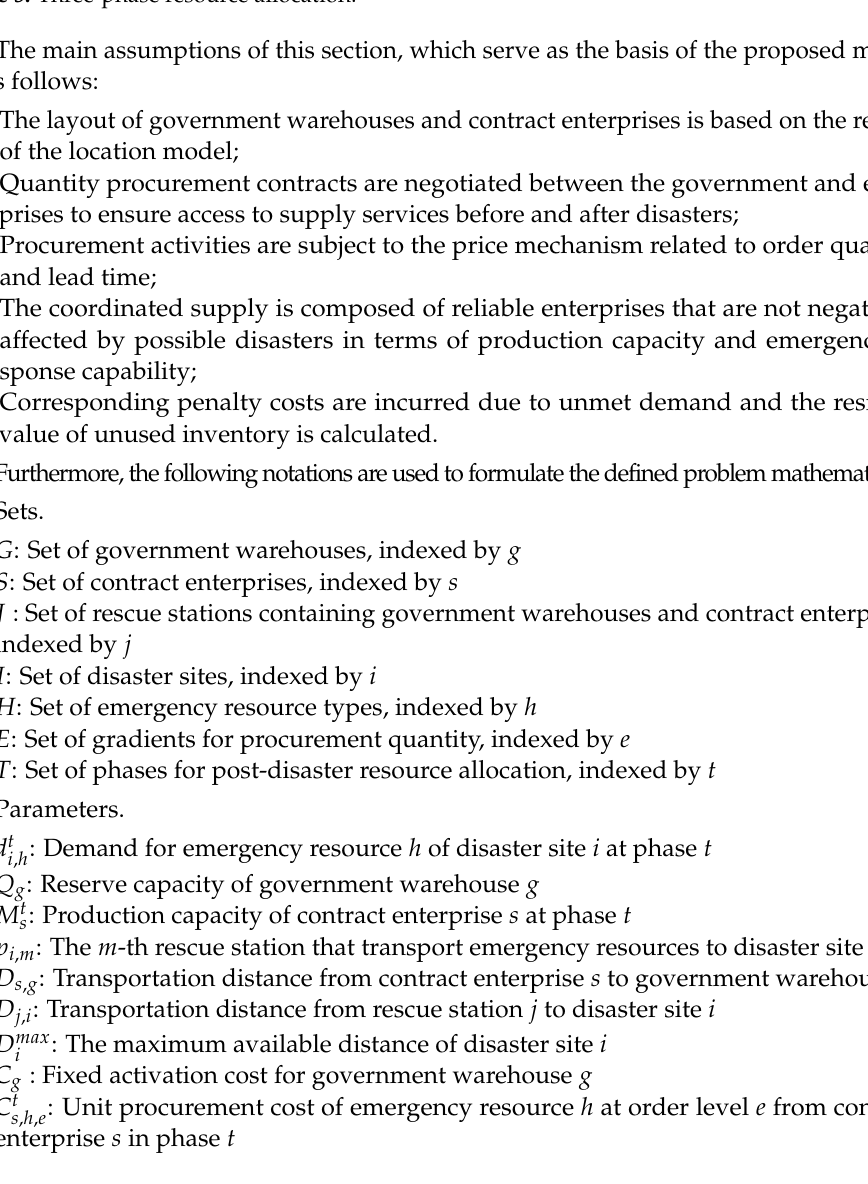
Figure 5. Three-phase resource allocation.